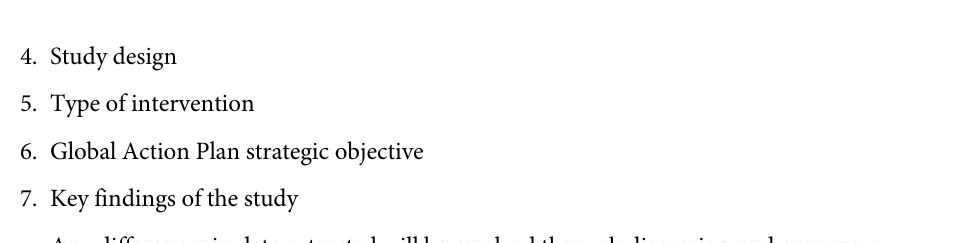
Fig 1. Flow diagram for the scoping review methodology on preventing and managing antimicrobial resistance in the African region.